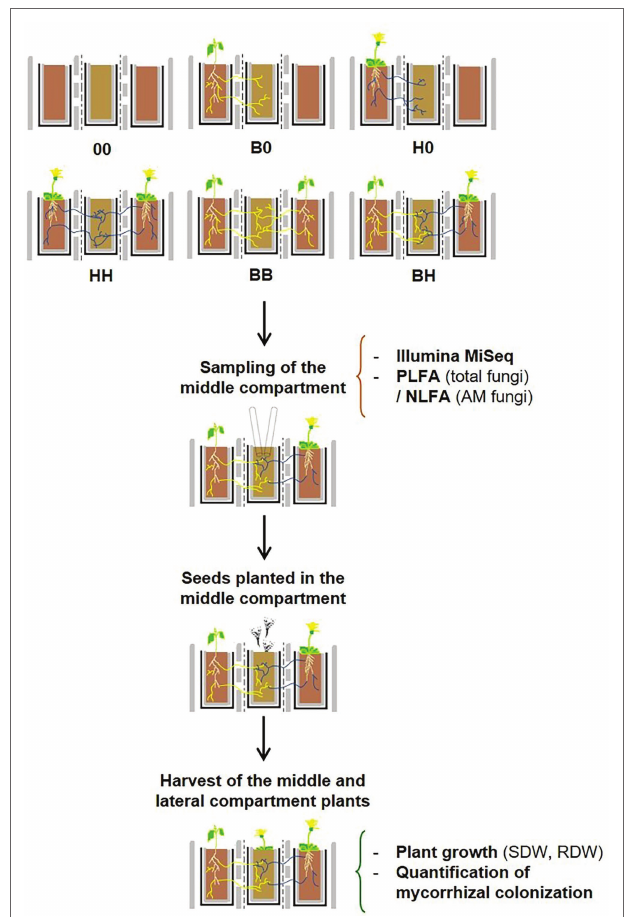
FIGURE 1 | Diagram of the experimental design. The two lateral compartments of three-compartment rhizoboxes were left unplanted or planted with Betula pendula hosting ectomycorrhizal fungi (yellow lines) and/ or with Hieracium caespitosum hosting arbuscular mycorrhizal fungi (blue lines) according to six different treatments (Stage I, n = 16). Seedlings of either B. pendula or H. caespitosum were planted into the middle compartments of each treatment after 5 months, thus resulting in 12 treatments in Stage II ( n = 8). Treatments: 00 = without plants in lateral compartments, B0 = B. pendula in only one lateral compartment, BB = B. pendula in both lateral compartments, BH = B. pendula and H. caespitosum in lateral compartments (interaction treatment), H0 = H. caespitosum in only one lateral compartment, HH = H. caespitosum in both lateral compartments. NLFA = neutral lipid fatty acid analysis, PLFA = phospholipid fatty acid analysis, RDW = root dry weight, SDW = shoot dry